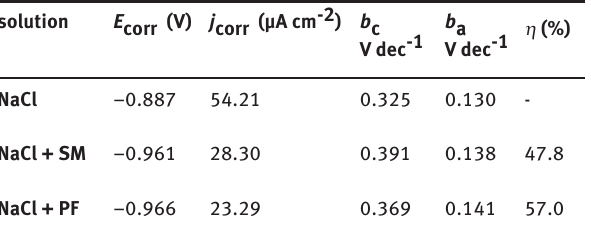
Table 1: Potentiodynamic polarization parameters for Fe electrode